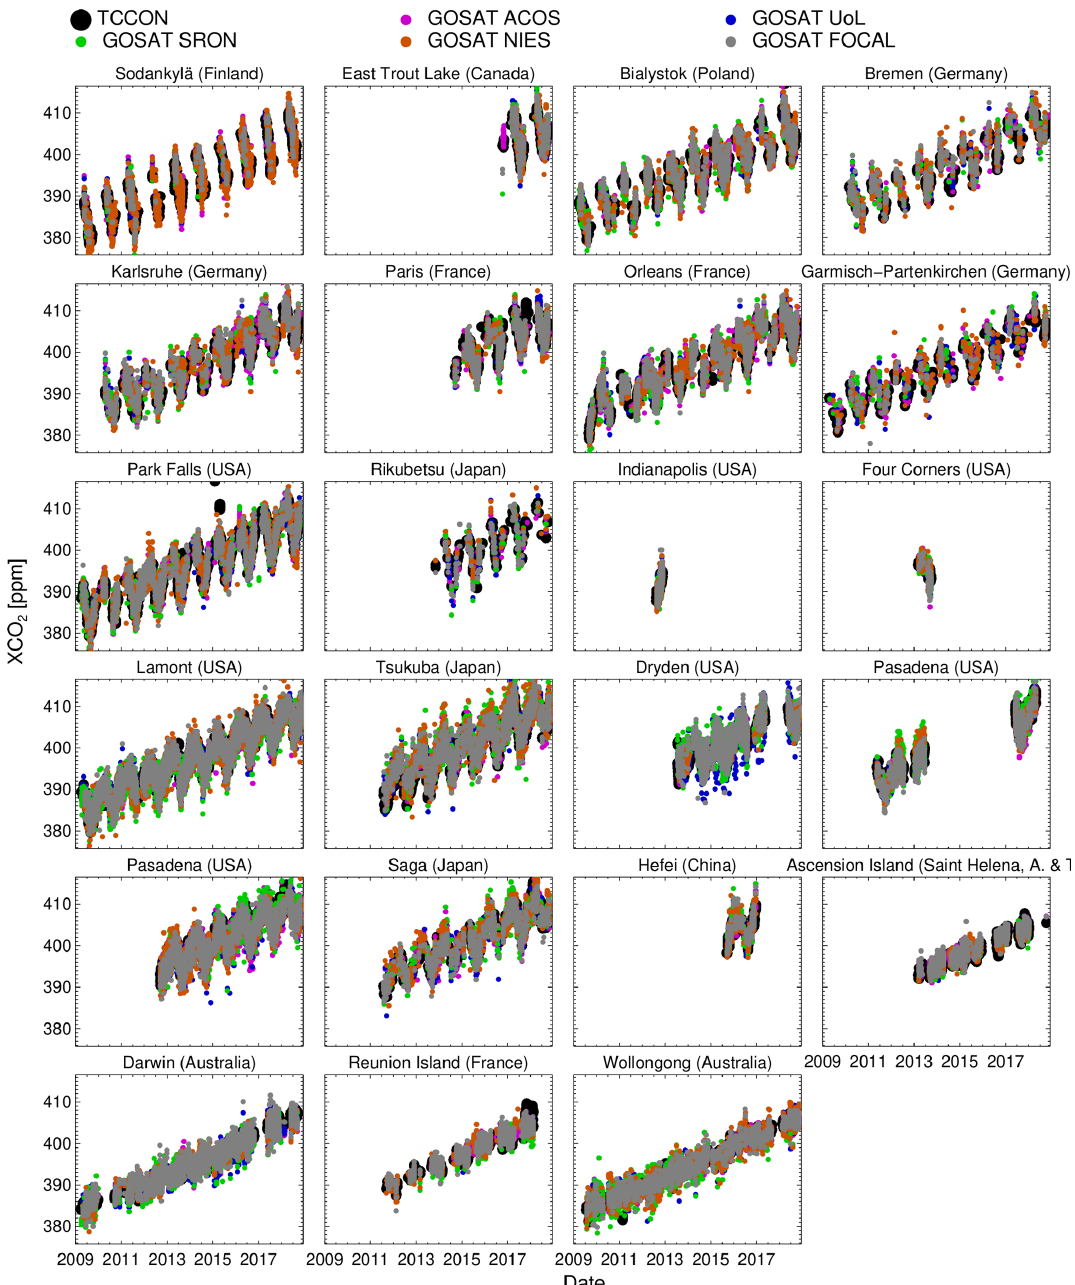
Figure 15. Time series of collocated GOSAT data at various TCCON sites for different data products including the new GOSAT-FOCAL data